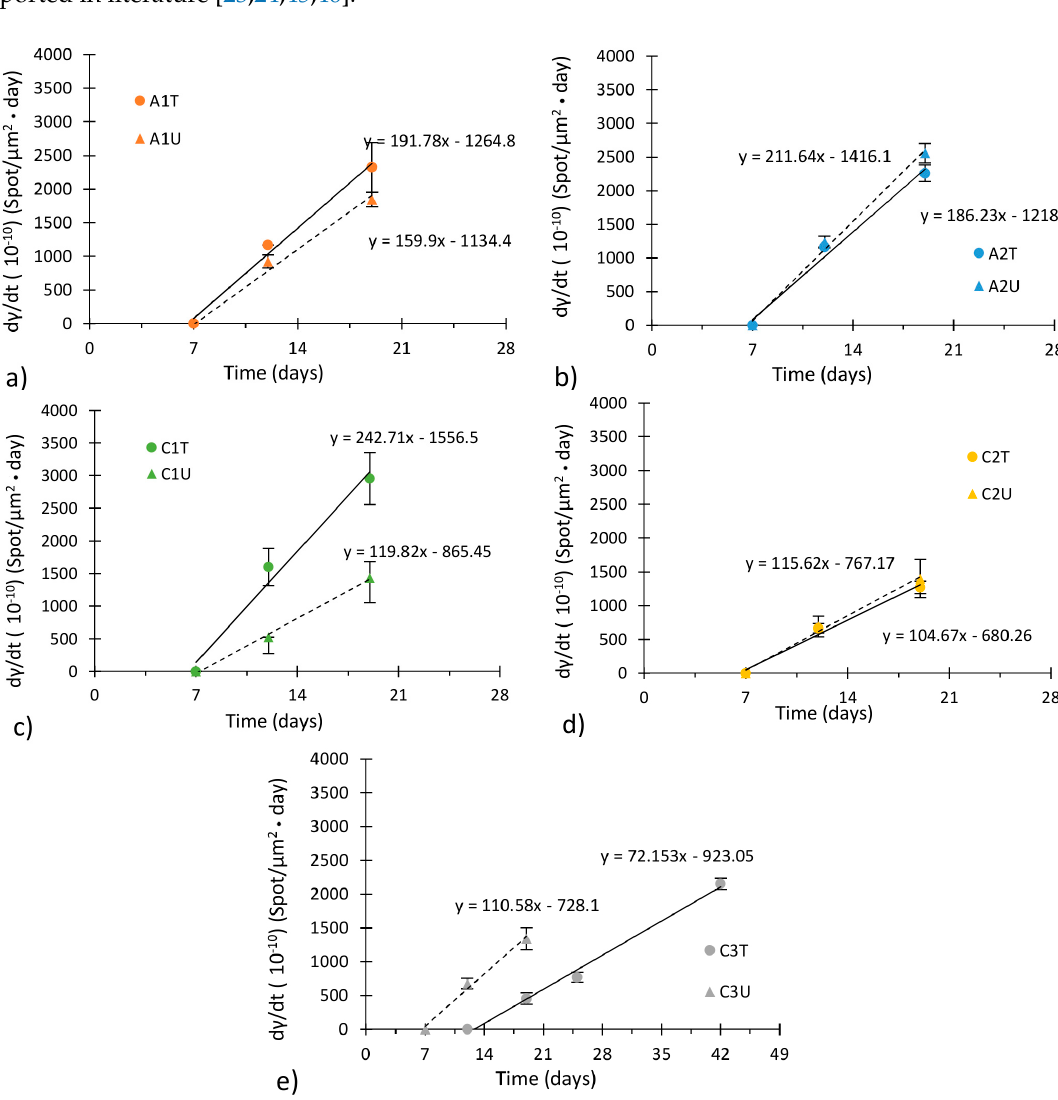
Figure 3. Number of algal spots with standard deviations (±): ( a ) A1 specimen; ( b ) A2 specimen; ( c ) C1 specimen; ( d ) C2 specimen; ( e ) C3 specimen. Regression lines and equations are reported for treated specimens (solid line), and untreated ones (dashed line).